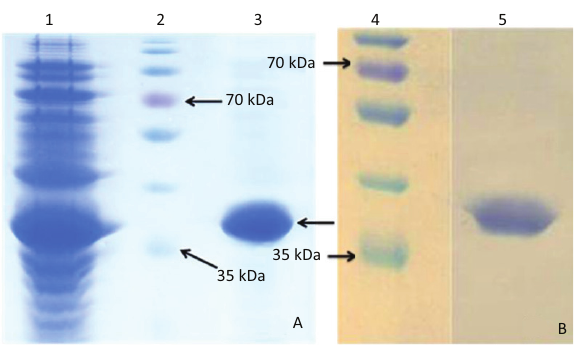
FIGURE 2: (a) Effects of IPTG concentration on expression. (b) Effects of different temperature on expression. (c) Effects of time on recombinant Clostridium perfringens beta toxin expression.